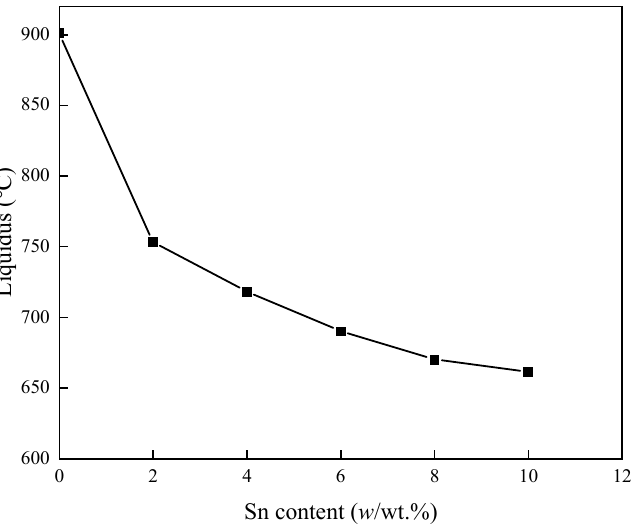
Figure 12. Liquidus temperatures of amorphous Cu-5P-2Ni filler metals with different contents of Sn [49].